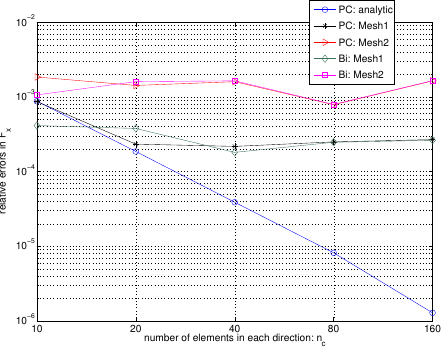
Figure 14. Tangential contact problem: errors in tangential force F x with different ICs. Here, “PC” and “Bi” denote piecewise constant and bilinear loads, respectively. The horizontal axis shows the number of elements in each direction of contact grid n c × n c